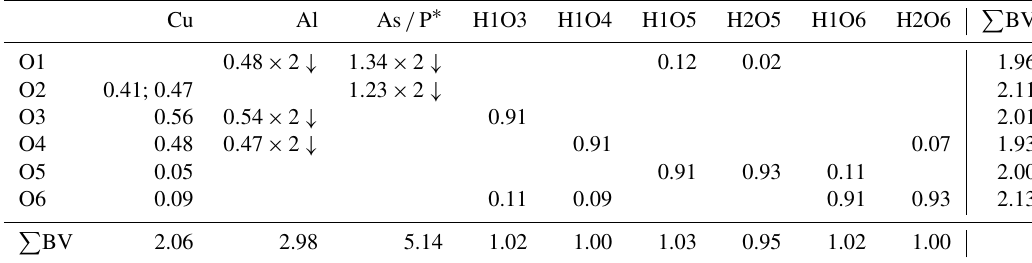
Table 5. Bond-valence analysis of the liroconite crystal structure.